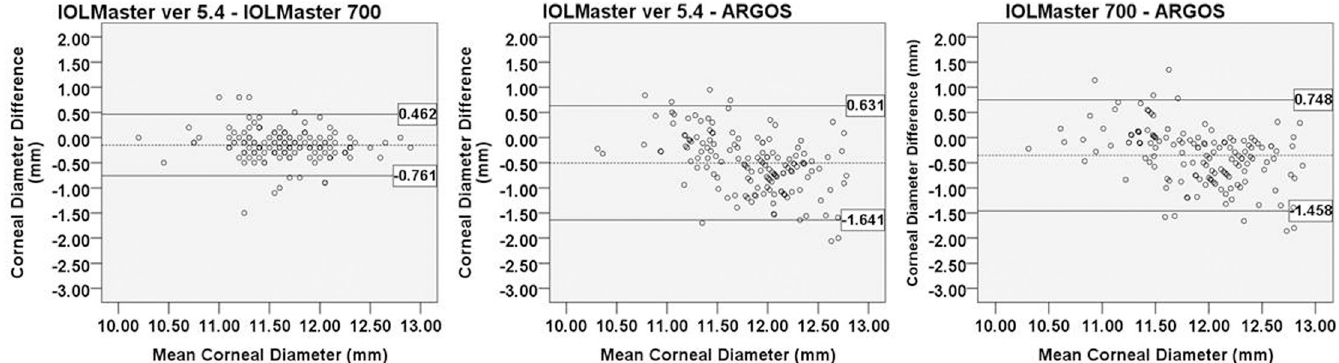
Fig 4. Bland-Altman plot for the WTW measurements of each devices. The mean difference is indicated by the dashed lines, and 95% LoA is indicated by the solid line. Comparison of IOLMaster ver. 5.4 and IOLMaster 700 (A); IOLMaster ver. 5.4 and Argos (B); and IOLMaster 700 and ARGOS (C).